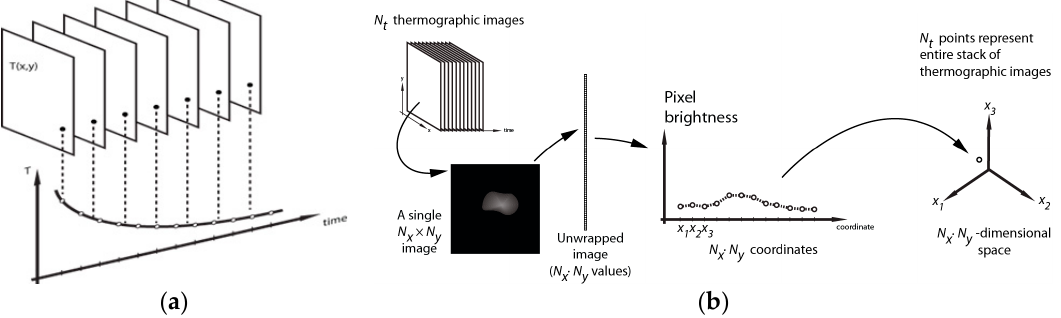
Figure 2. ( a ) Explanation of stack of thermal images; ( b ) Illustration of multidimensional representation of each thermal image in stack (only first three of all N x · N y dimensions are shown). The “cloud” of such points is suitable for extraction of the so-called principal components (PCs).